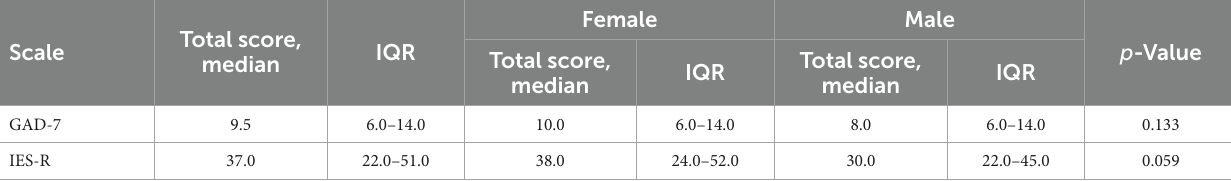
Severity category (score